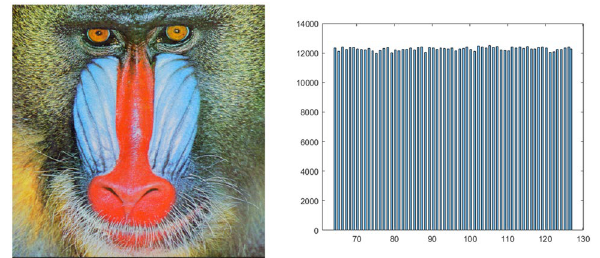
Fig. 8 ASCII code